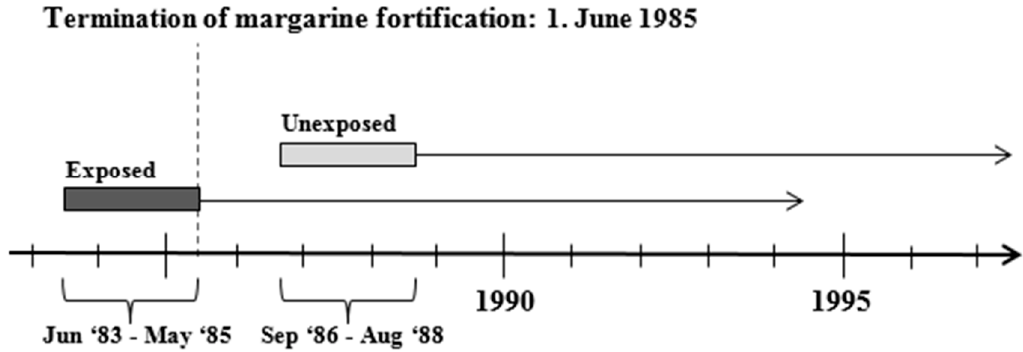
Figure 1. Study design and study population.